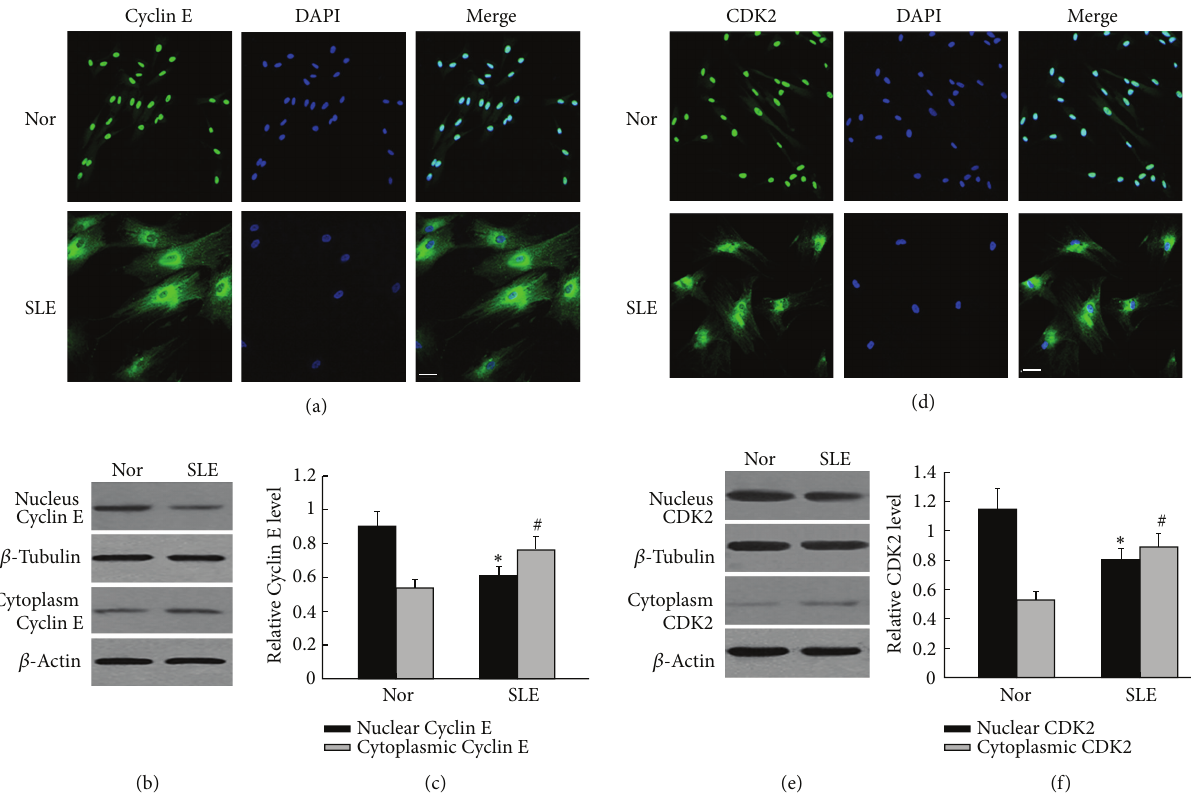
Figure 4: Analysis of the location and expression of Cyclin E and CDK2 in the cytoplasmic and nuclear of BM-MSCs from SLE patients. ((a), (d)) The locations of Cyclin E and CDK2 in BM-MSCs were tested by immunofluorescence staining. We found that the expression of Cyclin E and CDK2 was notably decreased in nuclear of BM-MSCs from SLE patients, while there were notably higher expressions in nuclears in normal control. The scale bar is 25mm. ((b), (e)) Western blot to analyze the expressions of Cyclin E and CDK2 in cytoplasmic and nuclear. ((c), (f)) Quantification the expressions of Cyclin E and CDK2 in the nuclear and cytoplasmic. Compared with normal control BM-MSCs, Cyclin E and CDK2 in the nuclear were significantly lower in SLE patients; the relative levels of protein expressions were normalized to 𝛽 -actin expression. Values are means ± SD of three experiments ( ∗ 𝑃 < 0.05